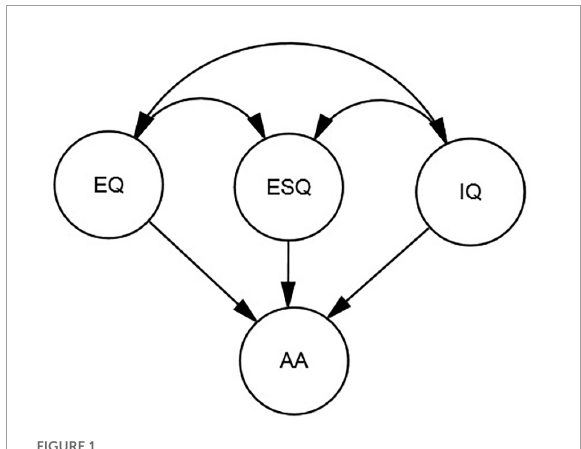
FIGURE1 A hypothesized model for the possible relationships among IQ, EQ, ESQ, and